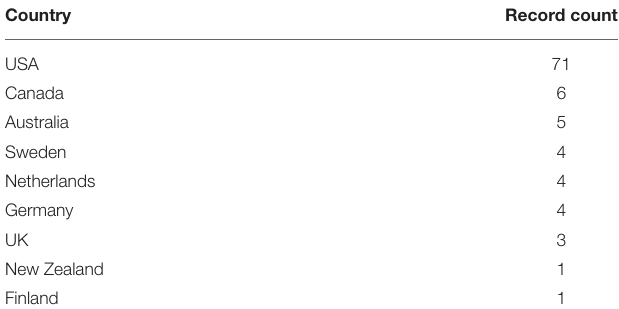
TABLE 1 | Country distribution of the top-cited articles. Country